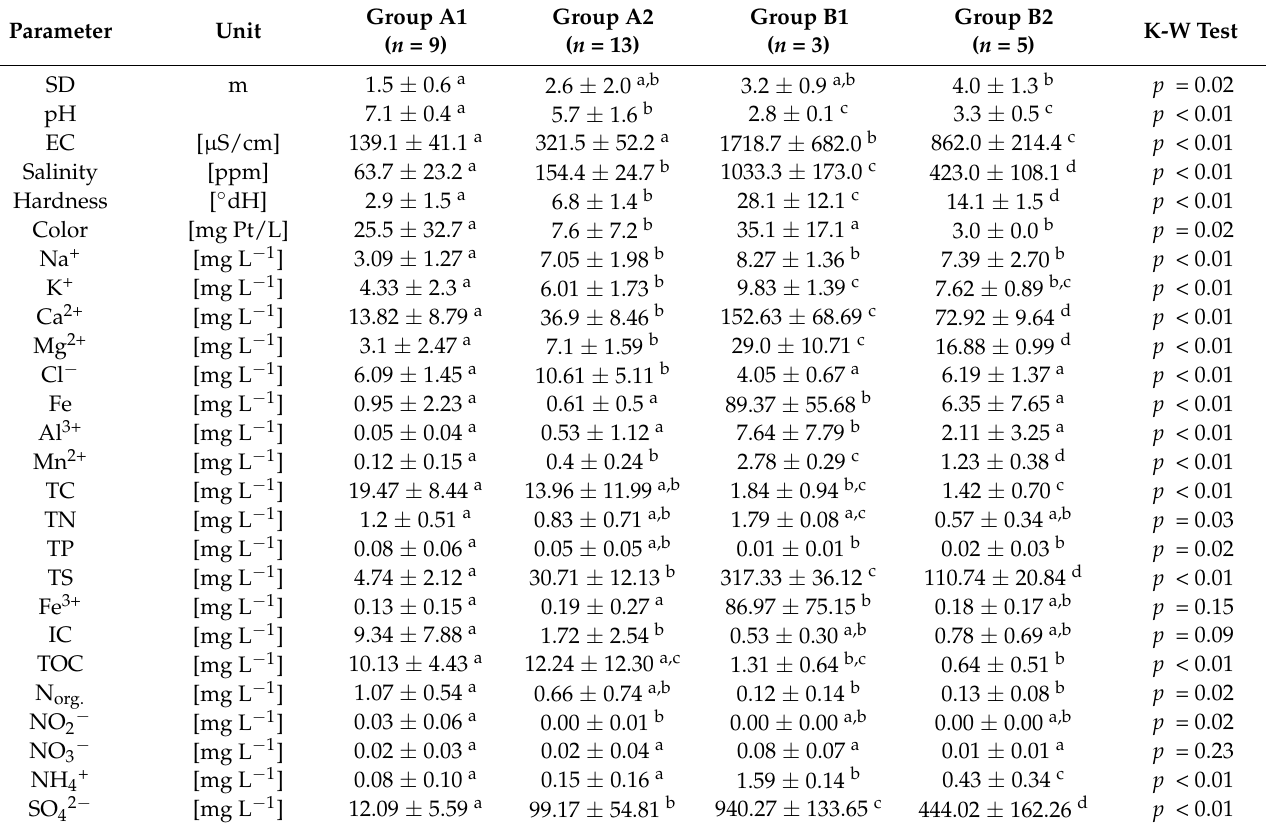
Table 1. Physico-chemical characteristics of the distinguished lake clusters. Mean values and standard deviations are given for all parameters. Different letters in superscript indicate significant ( p < 0.05) group-to-group differences in the post-hoc test: the same letters = no differences; different letters = significant